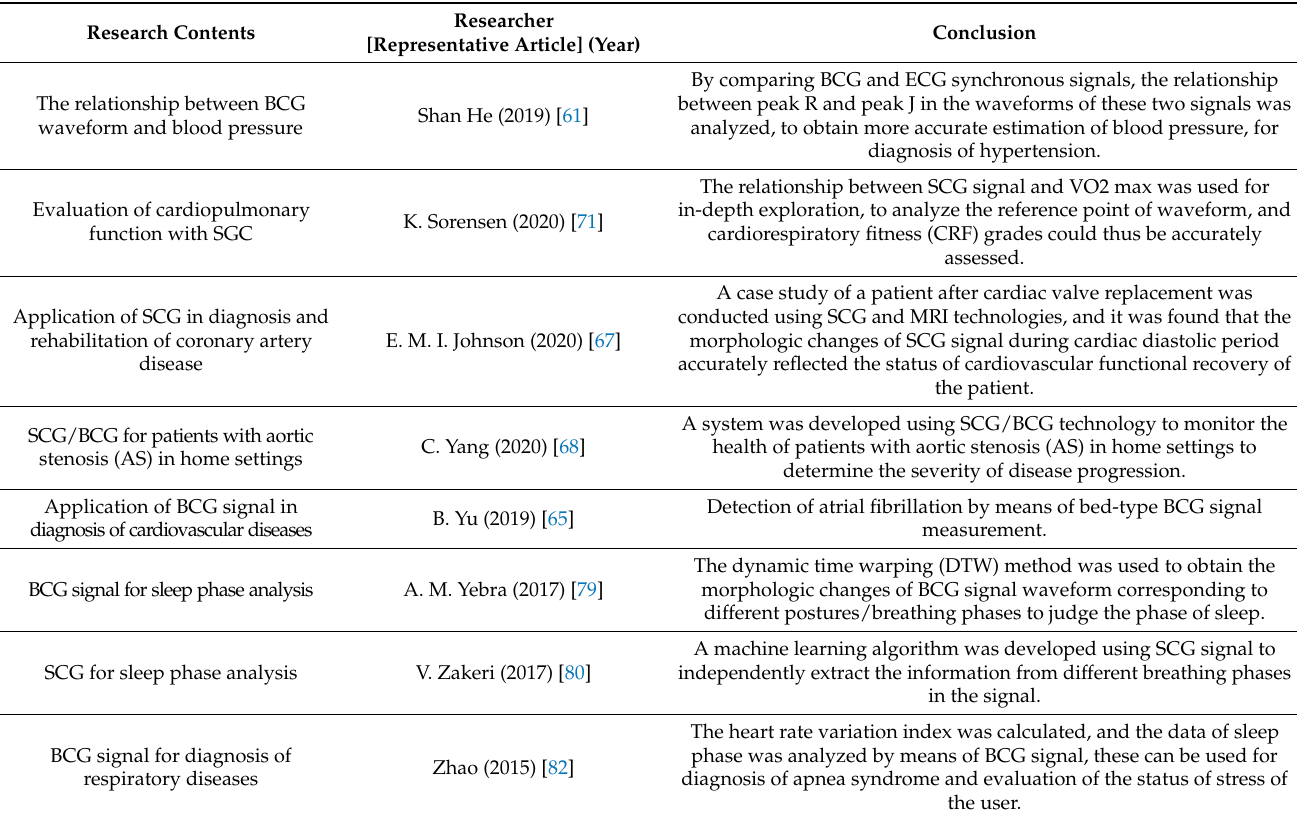
Table 2. Typical Research of Application of BCG/SCG in Clinic Medicine in the Tears